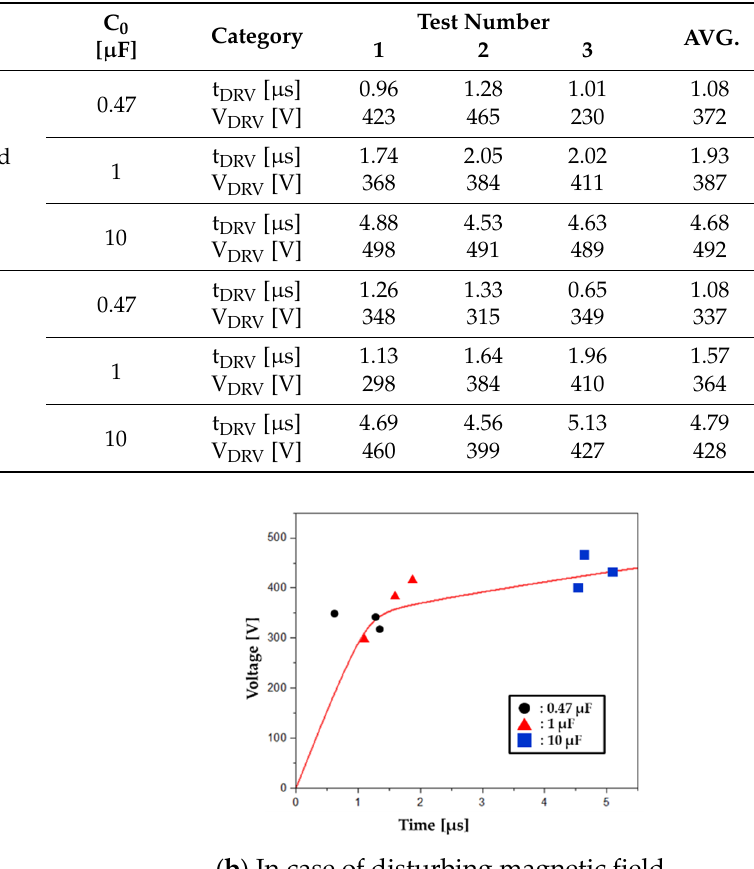
Table 5. Dielectric recovery voltage test results according to disturbed magnetic fields.